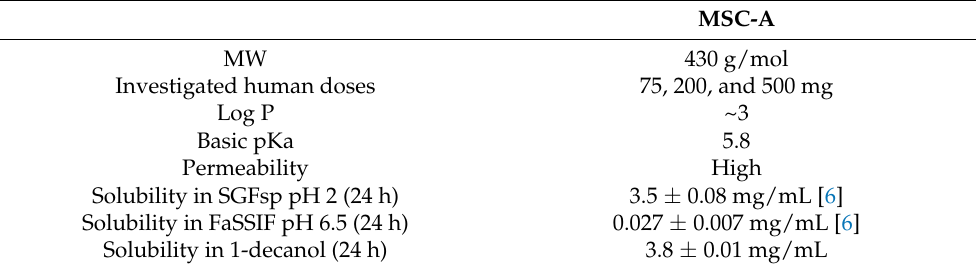
Table 1. Physico-chemical characteristics and solubility in various media of